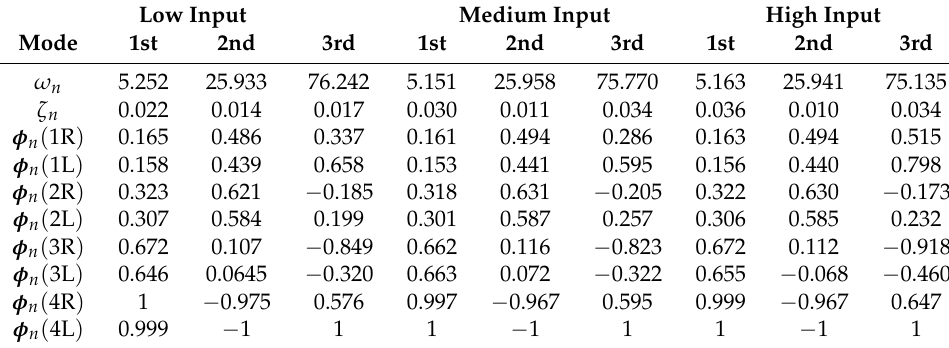
Table A3. Spar and tube: identified modal parameters.